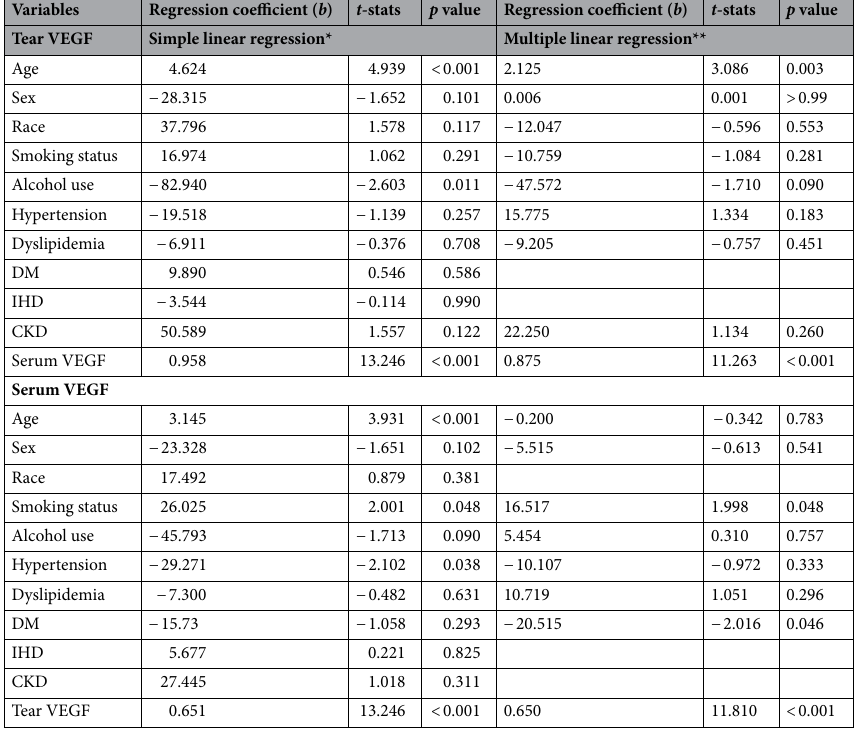
Table 4. Factors associated with tear and serum VEGF among AMD patients. DM Diabetes mellitus, IHD Ischemic heart disease, CKD Chronic kidney disease, VEGF Vascular endothelial growth factor. *Simple linear regression; p value < 0.25 was considered significant. **Multiple linear regression; p value < 0.05 was considered significant. Enter, Stepwise, Backward, and Forward analyses were